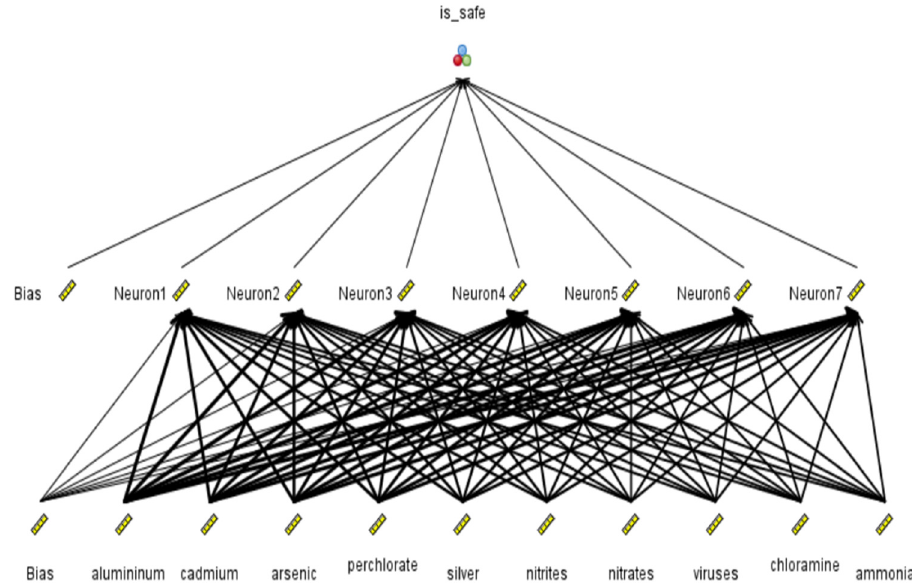
Figure 2: MLP for water quality prediction.